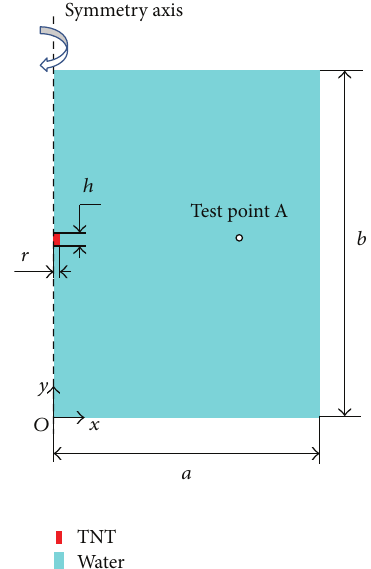
Figure 2: Model of column charge underwater